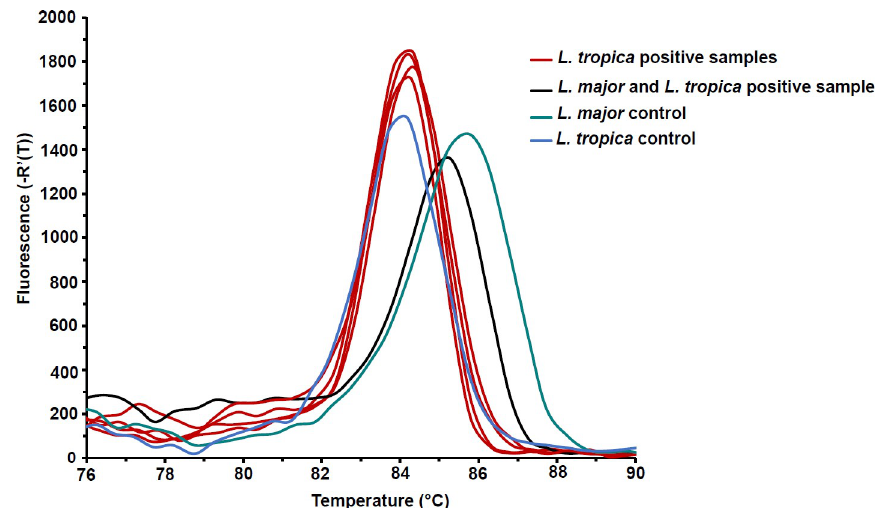
Fig 5. Real-time PCR-HRM analysis of Leishmania infection in female sandflies. A derivative dissociation curve of 179 bp L . tropica (Tm = 84.2˚C) and 195 bp L . major (Tm = 85.8˚C) ITS1 -PCR amplicons. Infection was inferred by comparing the melting profiles of the samples to the controls.